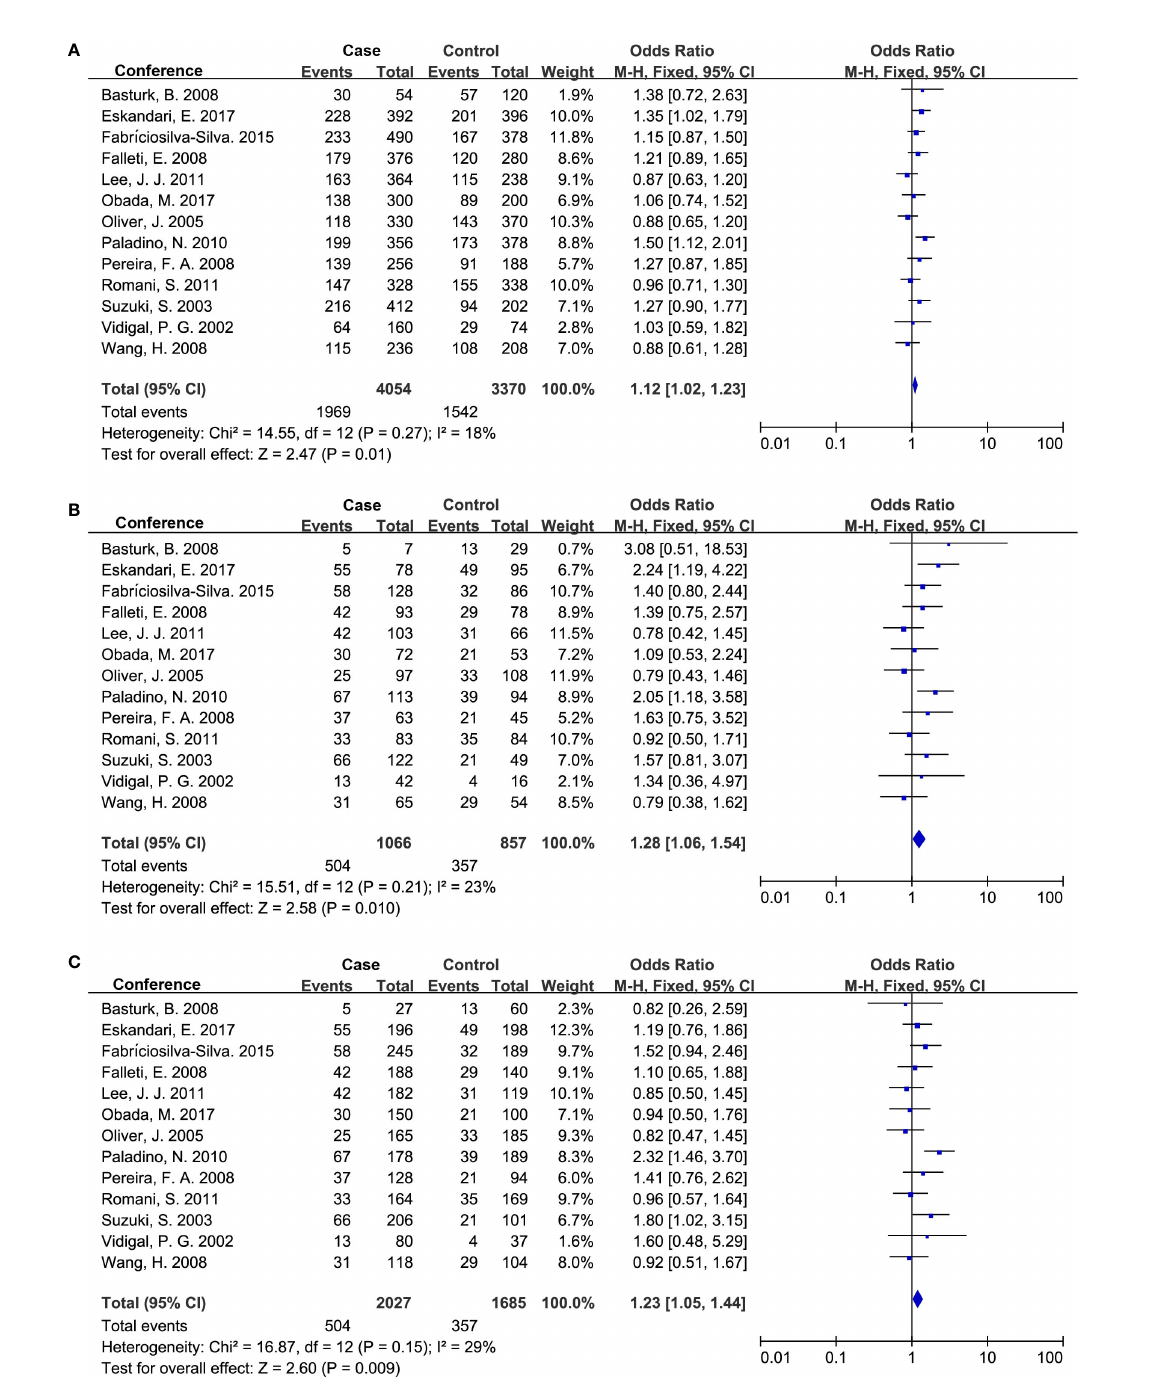
FIGURE 3 Forest plot of OR with 95% CI for associations between TGF- b 1 codon 10 polymorphism. (A) dominant model, Pro vs Leu) and CLD risk; (B) homozygote model, Pro/Pro vs Leu/Leu; (C) recessive model, Pro/Pro vs Leu/Leu+Leu/Pro. OR, pooled odds ratios; 95% CI, 95% con fi dence interval; Pro, Proline; Leu,